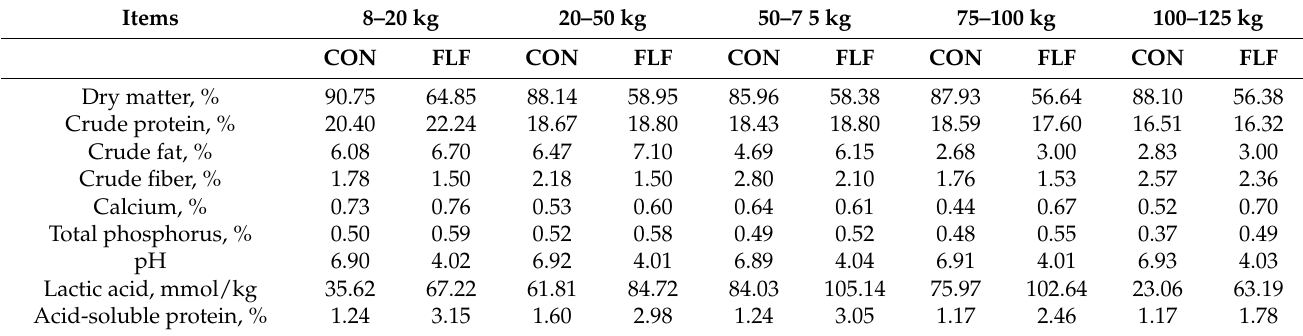
Table 3. Nutrient composition of basic feed and fermented